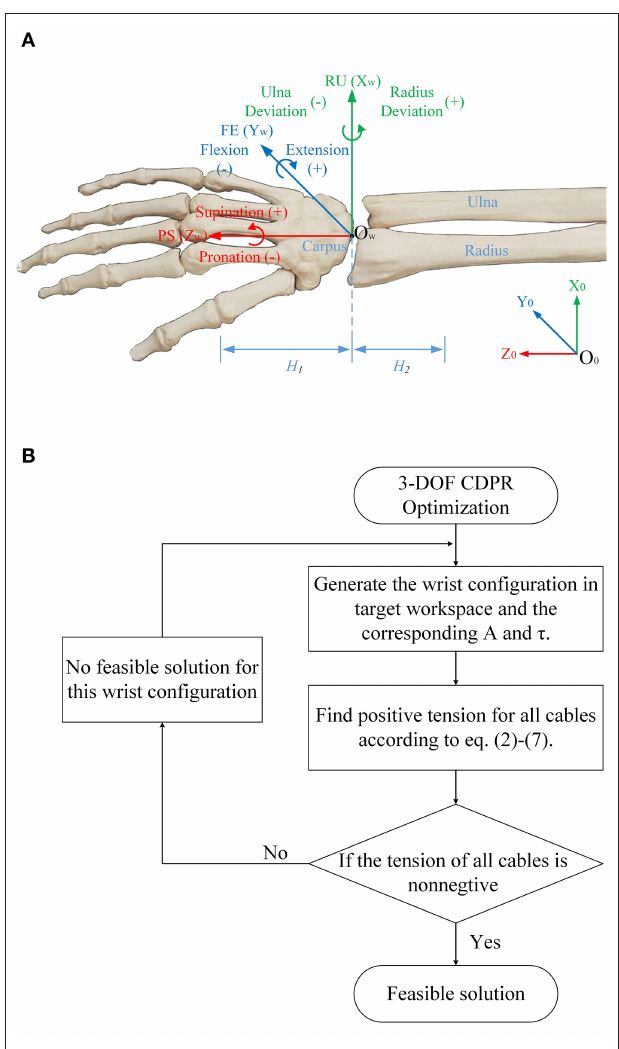
FIGURE 5 | (A) anatomy of the wrist joint and the coordinate frames, (B) the optimization process of the